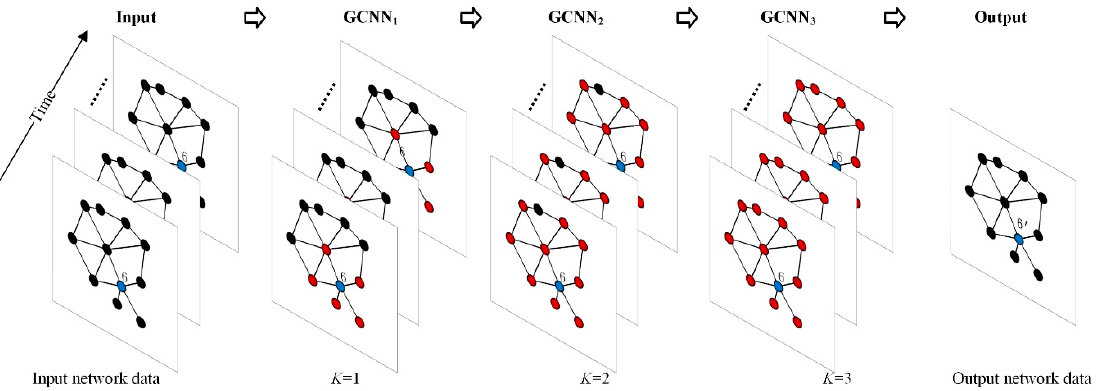
Figure 4. Procedure for capturing the spatiotemporal dependencies of metro network data using graph convolutional neural networks (GCNNs) (taking Station 6 as an example).